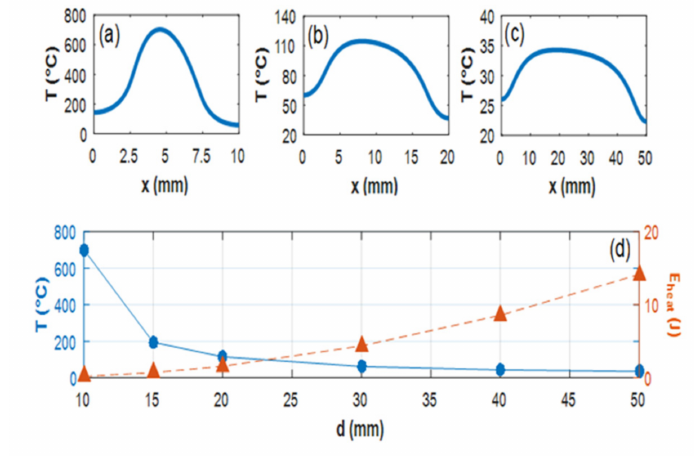
Figure 4. Simulated temperature profiles on the front surface of the Ti:Sa TD with the rear surface water-cooled. The repetition rate was set to 900 Hz ( a ), 100 Hz ( b ), and 11 Hz ( c ), respectively. Peak temperatures and the dissipated pump pulse energies for the different crystal diameters are shown ( d ).